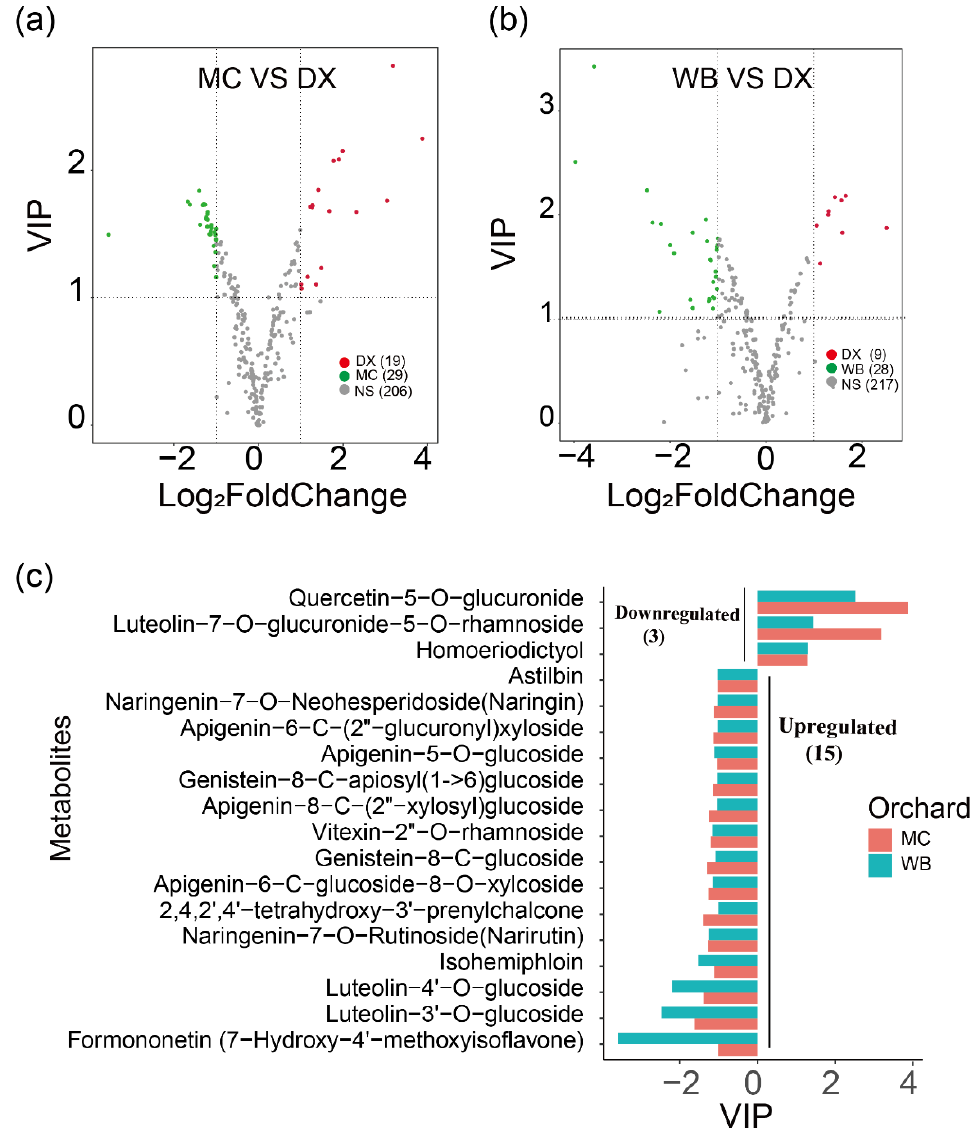
Figure 1. Differences in flavonoid content among three orchards. ( a ) Comparison of metabolite differences between Maichong (MC) orchard and Daxin (DX) orchard. The red dots represent the up-regulated metabolites in Daxin orchard, the green dots represent the up-regulated metabolites in Maichong orchard, the grey dots represent the metabolites with no significance, and the numbers in brackets are the metabolite numbers. VIP, variable importance in projection. ( b ) Comparison of metabolite differences between Wubao (WB) orchard and Daxin (DX) orchard. The abscissa is the log value of the fold change, and the ordinate is the VIP value. The metabolites with |log (fold change) | ≥1 indicate differential metabolites. The red dots represen t the up-regulated metabolites in Daxin orchard, the green dots represent the up-regulated metabolites in Wubao orchard, the grey dots are the metabolites with no difference, and the numbers in brackets are the metabolite numbers. ( c ) The abscissa is VIP, and the ordinate is the metabolites. The red bar represents the up-regulated or down-regulated metabolites from Maichong, and blue represents the up-regulated or down-regulated metabolites from Wubao. VIP ≤ − 1 indicates that the metabolite up-regulated by Maichong or Wubao, VIP ≥ 1 means the metabolite is down -regulated in Maichong or Wubao.